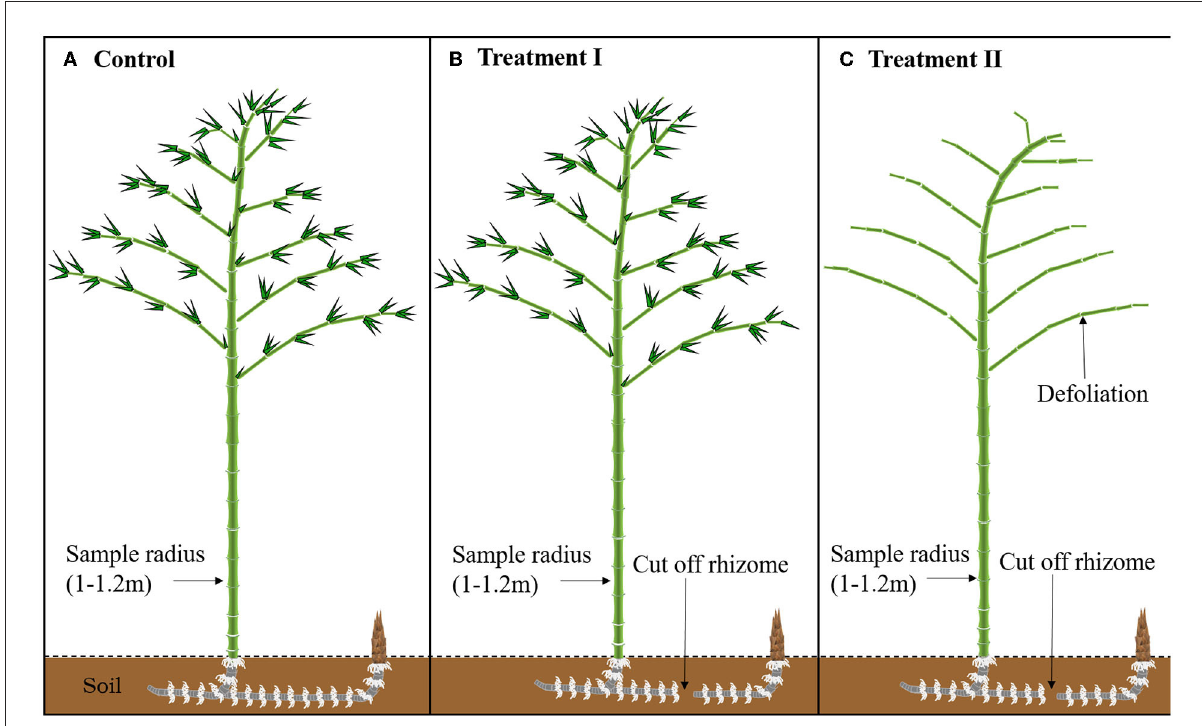
FIGURE1 Experimental design of the three treatments. (A) The control without any treatment (Control), (B) the cutting off rhizomes between the newly sprouted and mother culms (Treatment I), and (C) the removing all leaves of mother culms based on the Treatment I (Treatment